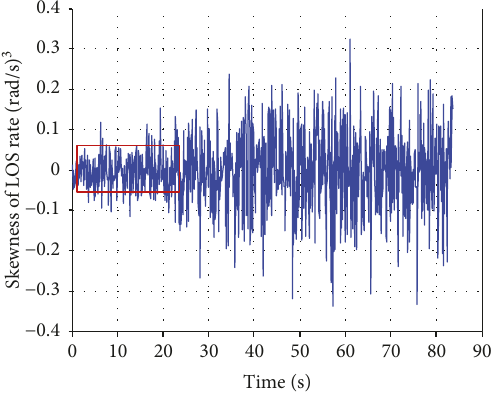
Figure 8: Skewness of the LOS rate.